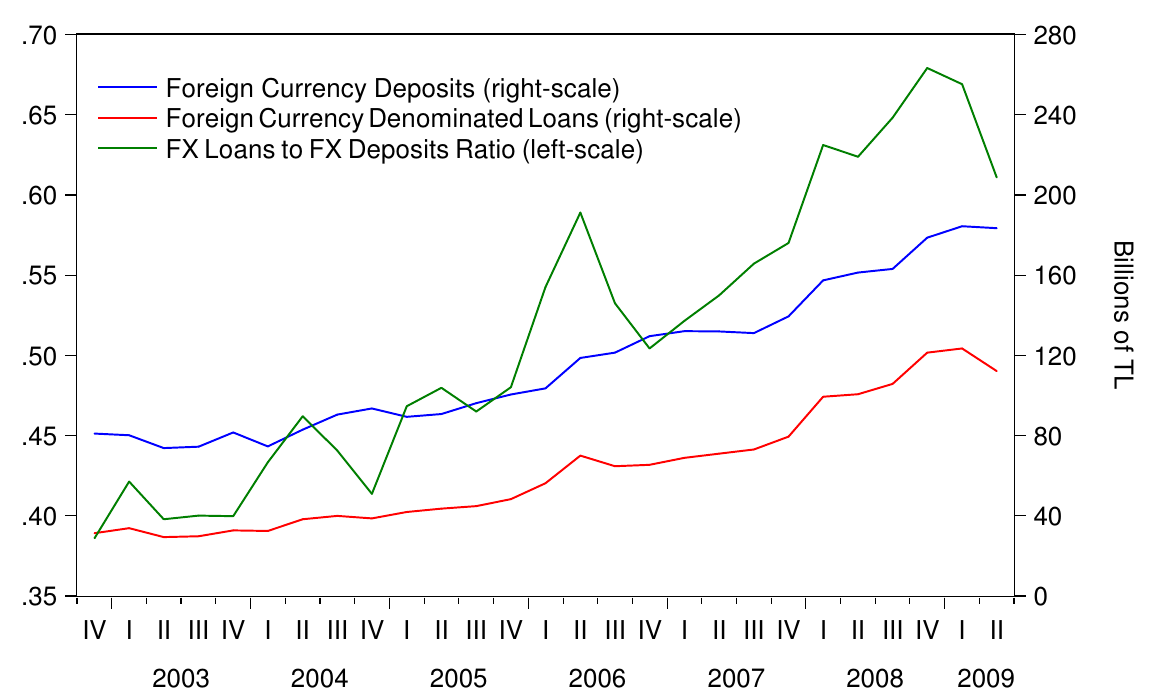
Figure 9. FC loans to FC deposits